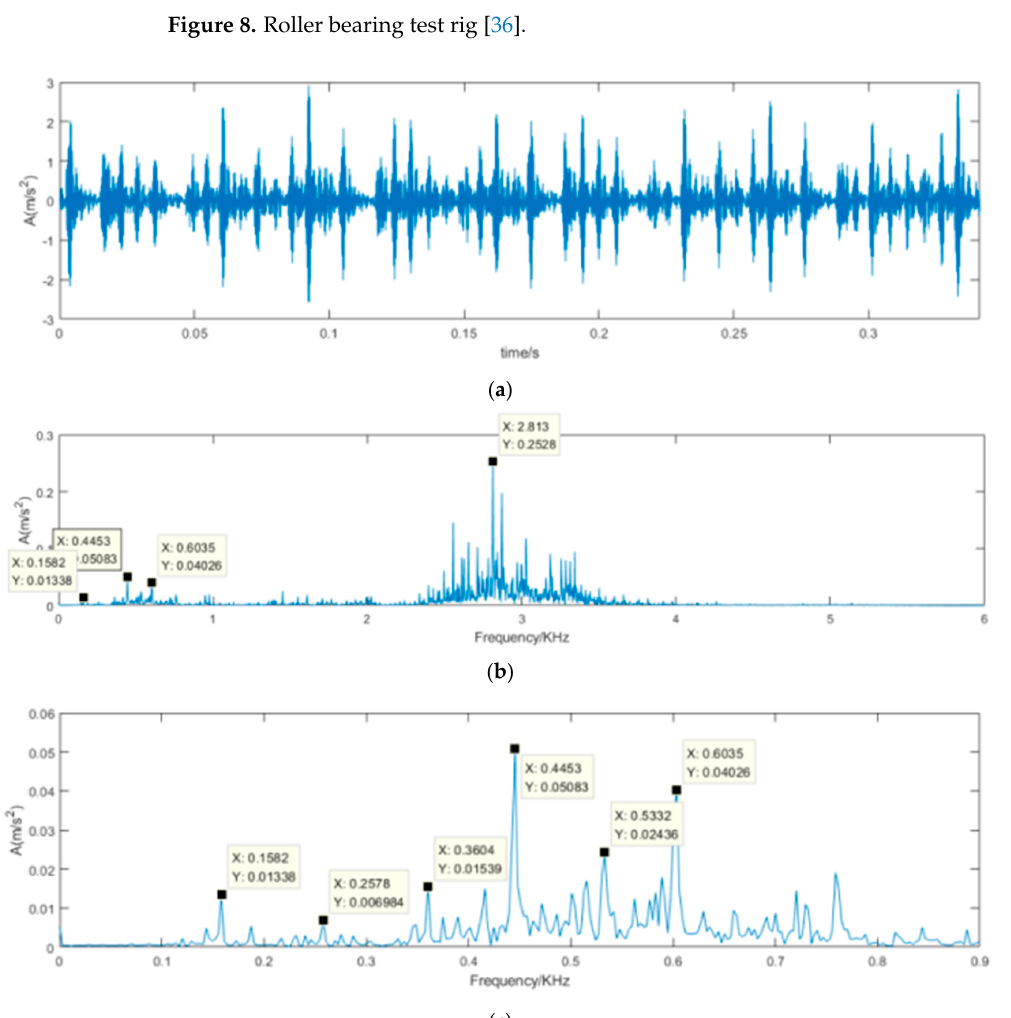
Figure 9. Time-domain waveform and frequency spectrum of vibration signal with inner ring failure. ( a ) Time-domain waveform of vibration signal with inner ring failure; ( b ) Frequency spectrum of vibration signal with inner ring failure; ( c ) Frequency spectrum limited in 0.9 KHz of vibration signal with inner ring failure.